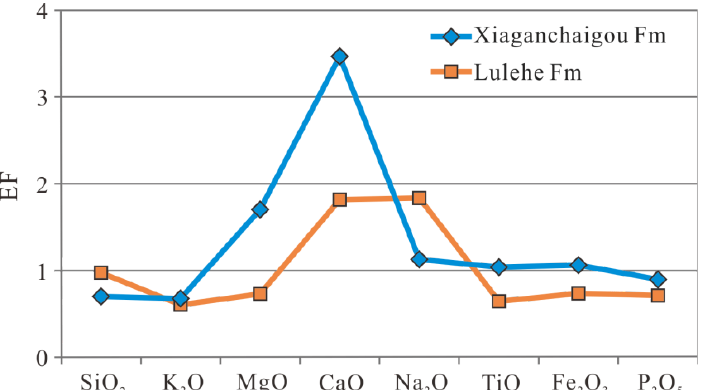
Figure 5. Comparison of main oxide contents in the Pingtai area with average shale. EF (enrichment factor) = C sediment /C standard rock .